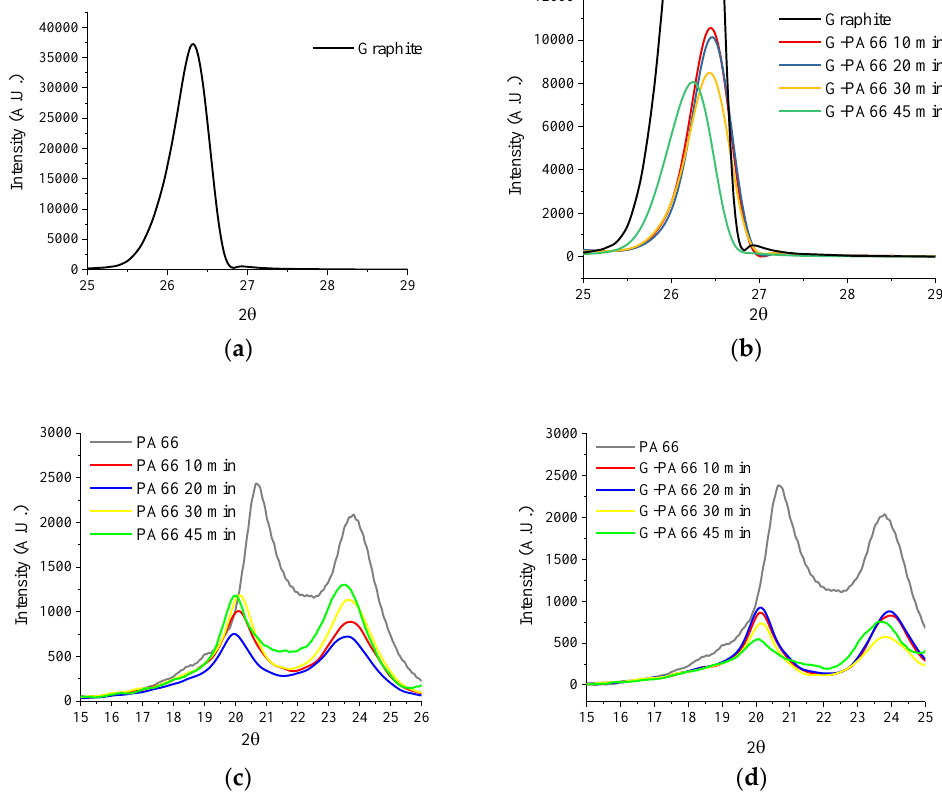
Figure 3. XRD diffraction patterns ( a ) Graphite ( b ) Graphite, G-PA66 10 min, G-PA66 20 min and G-PA66 30 min at Graphite’s (002) c-axis peak-scaled for composite exfoliation ( c ) PA66, PA66 10 min, PA66 20 min and PA66 30 min at the (100) & (010) lattice peaks for PA66 ( d ) PA66, G-PA66 10 min, G-PA66 20 min and G-PA66 30 at the (100) & (010) lattice peaks for PA66.